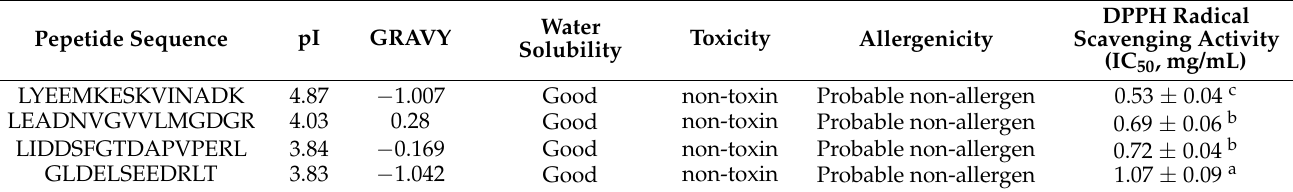
Table 2. Physical and chemical properties of antioxidant peptides from G. livida .